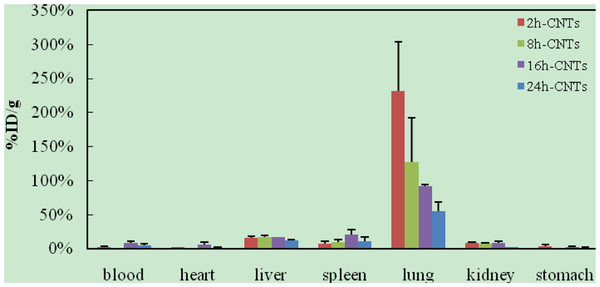
Biodistribution of oMWCNTs in mice at 2, 8, 16, and 24 h post i.v. with 99mTc-oMWCNTs.